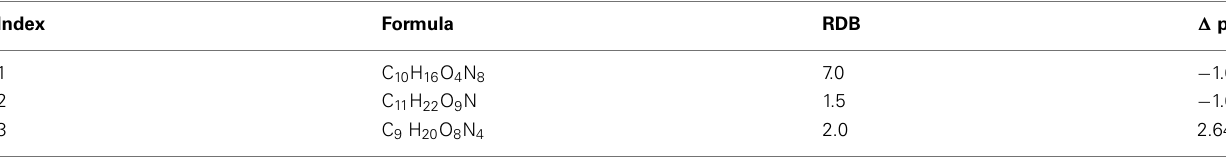
TableA5 | Chemical formulae calculated with m/ z